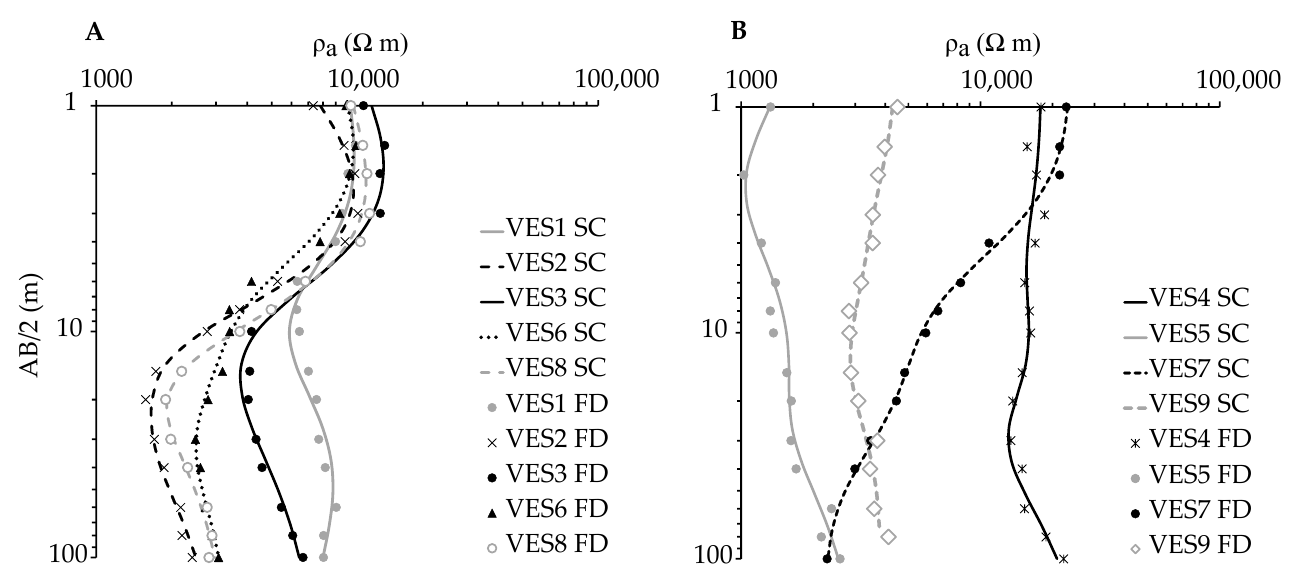
Figure 2. Vertical electrical sounding (VES) field data (FD) and synthetic curves (SC). The similar pattern between ( A ) VES sta-tions in an Oxisol (VES 1, 2, 3, 6, and 8) and ( B ) VES stations in an Entisol (VES 4, 5, and 9). VES 7, with Inceptisols, presented a different curve shape than the other VES stations. AB/2 represents an estimate of the theoretical depth of